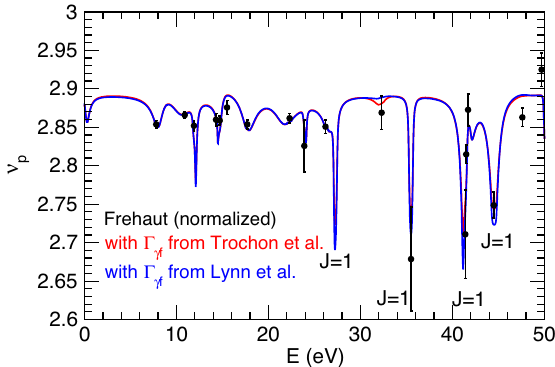
Figure 5. Comparison between the ν p results obtained in this work and the normalized experimental data from Fréhaut up to 50 eV.